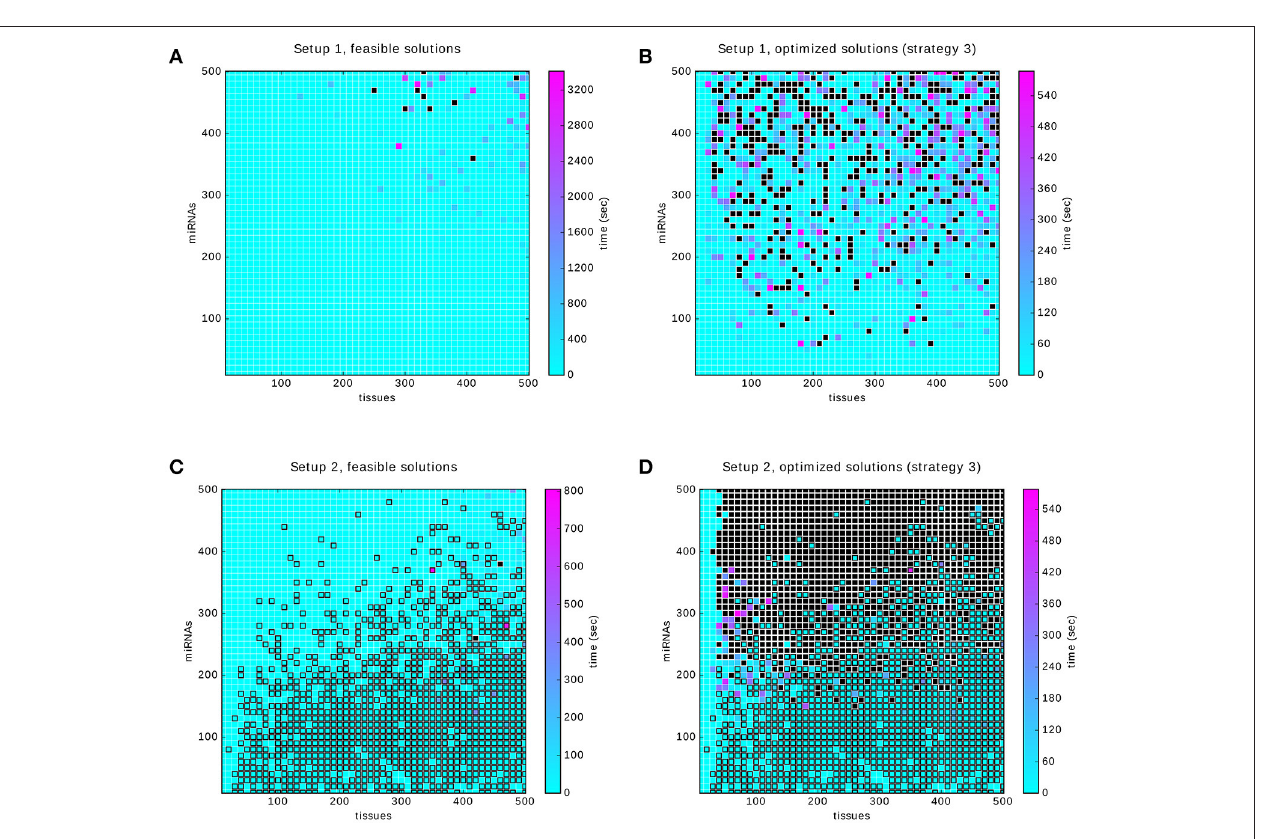
FIGURE 10 | Results of the benchmarking. Black filled squares indicate that the time-out was reached. Squares outlined in black indicate that the infeasibility of the problem was proved within the time limit. (A,B) relate to Setup 1. They show the time to compute a feasible and an optimized solution, respectively. (C,D) show the times to find feasible and optimal solutions for Setup 2. In both setups the optimization strategy 3 was used (first gates, then